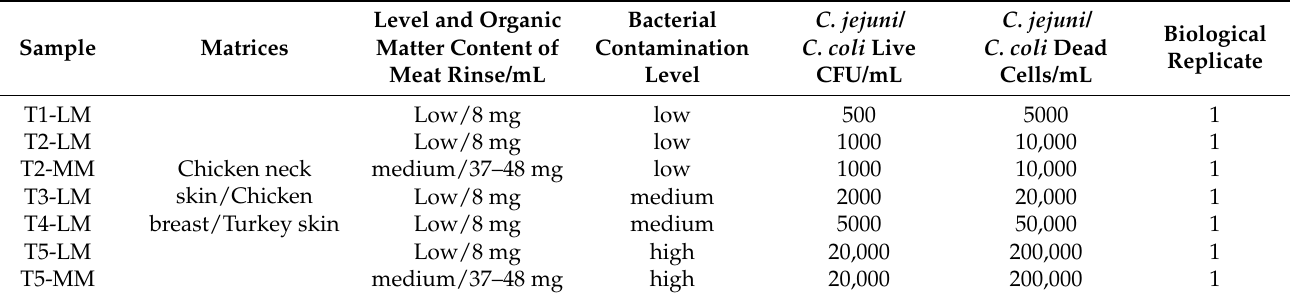
Table 3. Spiking plan for the trueness study. For each sample, 3 mL each of chicken neck skin, chicken breast, and turkey skin meat rinse were artificially contaminated with live- and dead-cell standards of C. jejuni and C. coli ,